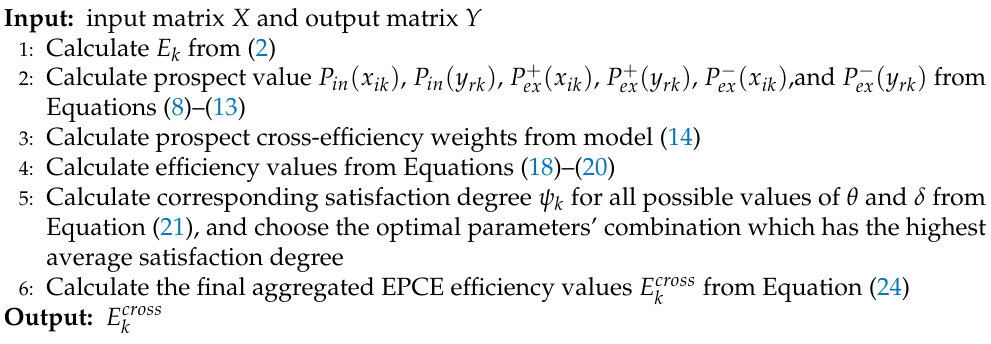
Algorithm 1 : Entropy-based prospect cross-efficiency evaluation